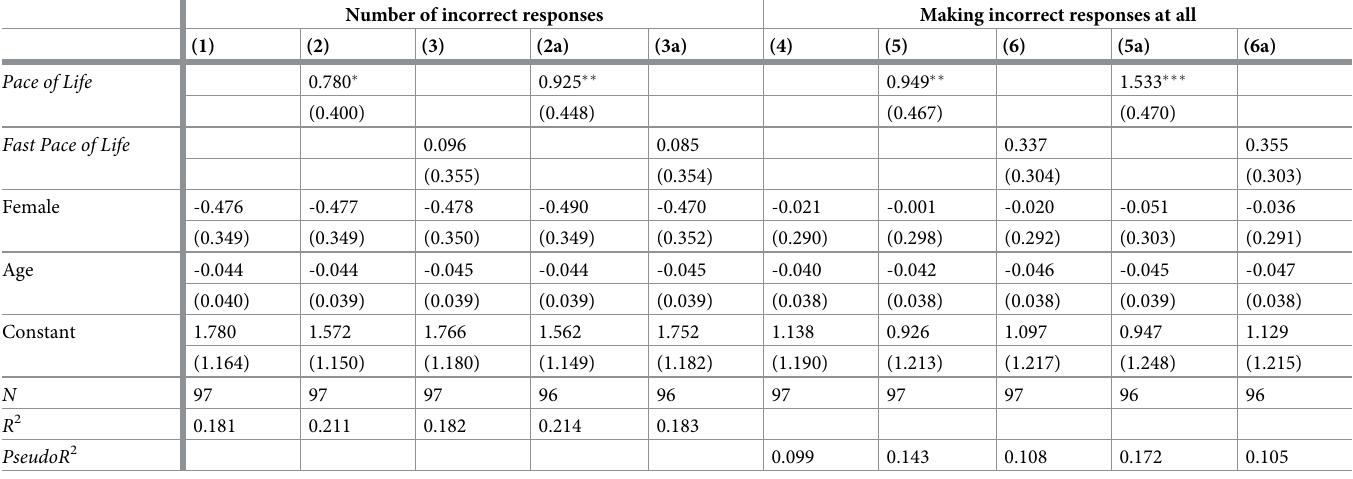
Table 1. Regression results for